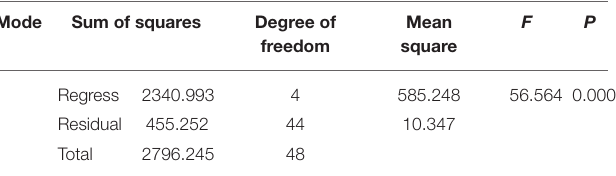
TABLE 5 | Analysis of variance of the regression model for predicting the risk of depression in patients with short-term insomnia. Mode